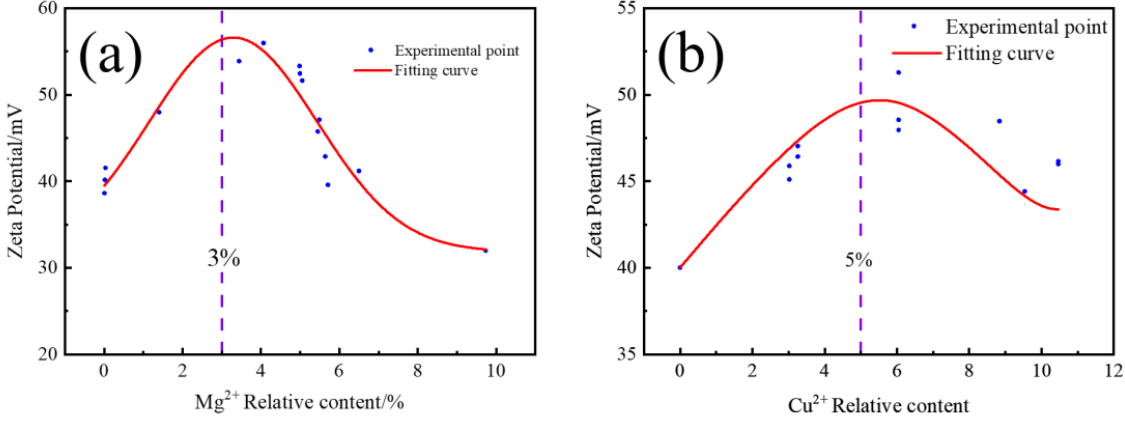
Figure 5. Zeta potential of EPD suspension with different relative contents of Mg 2+ ( a ) and Cu 2+ ( b ). In order to explain the lower rate of later EPD with the addition of Cu 2+ , or the higher zeta potential with a higher relative content of Cu 2+ (such as 10%) than without Cu 2+ but with a lower EPD rate than without Cu 2+ , we analyzed the coating elements. Table 1